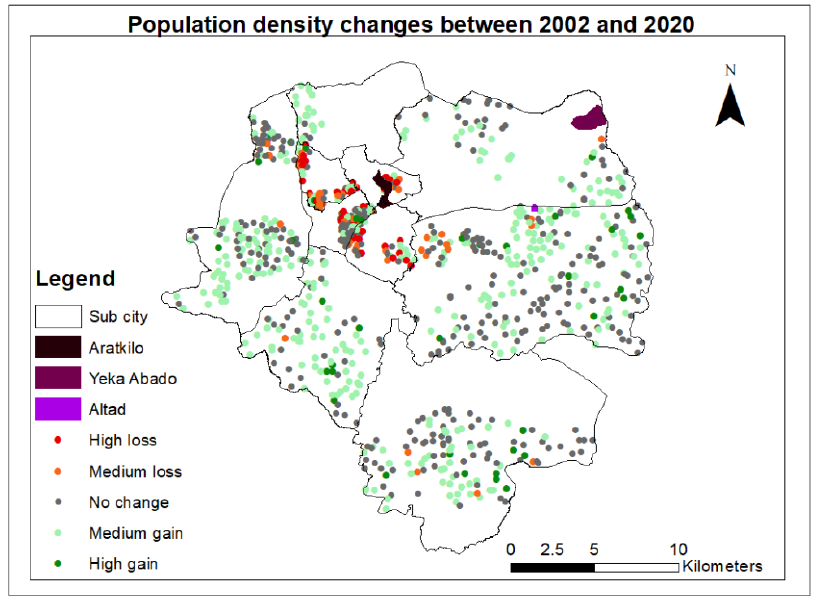
Figure 9. Population density changes between 2002 and 2020.